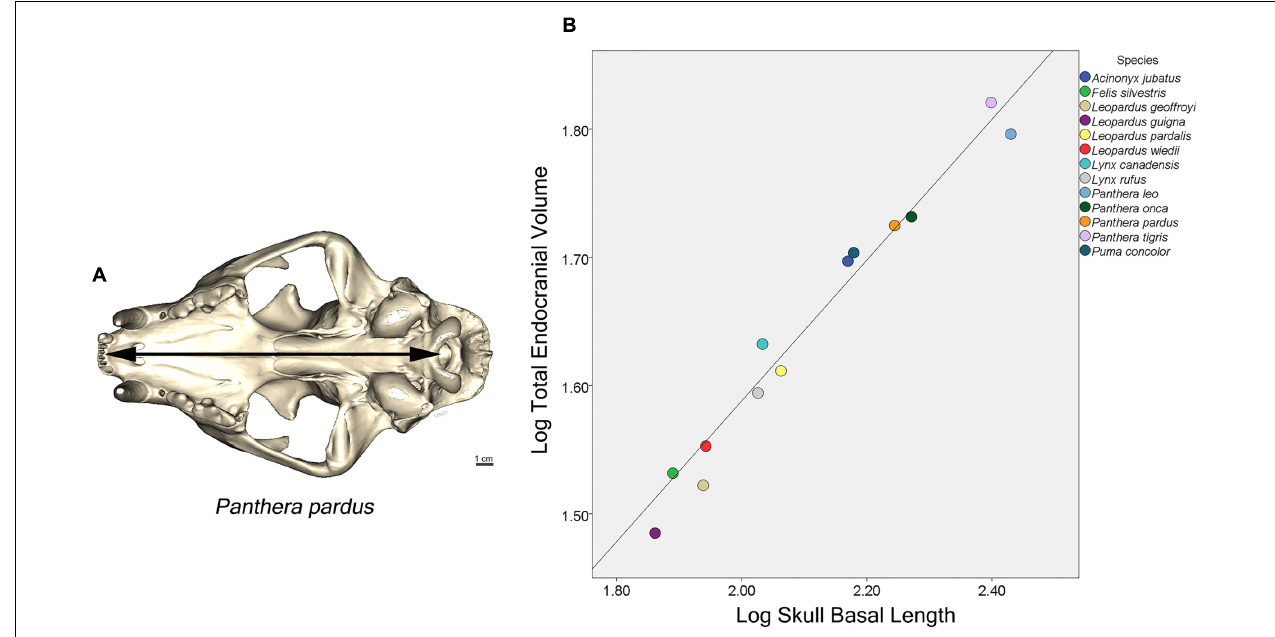
FIGURE 2 | (A) Ventral view of a leopard skull showing the linear measure of skull basal length (SBL), the distance from the median incisive alveolus to the mid-ventral border of the foramen magnum (arrow). (B) Plot of log cube root of endocranial volume regressed against log skull basal length of 13 felid species. (Pearson’s r = 0.96, p < 0.001).